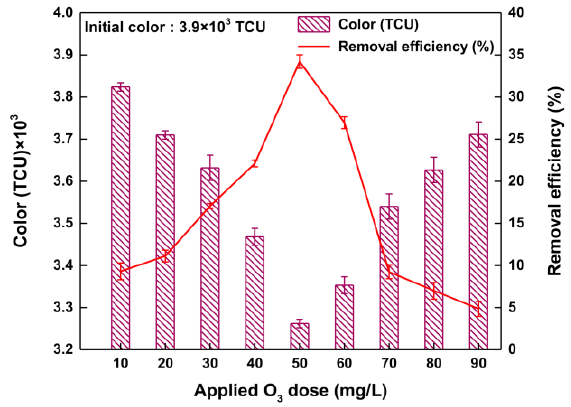
Figure 6. Removal efficiency of color with various applied O 3 doses for O 3 oxidation.